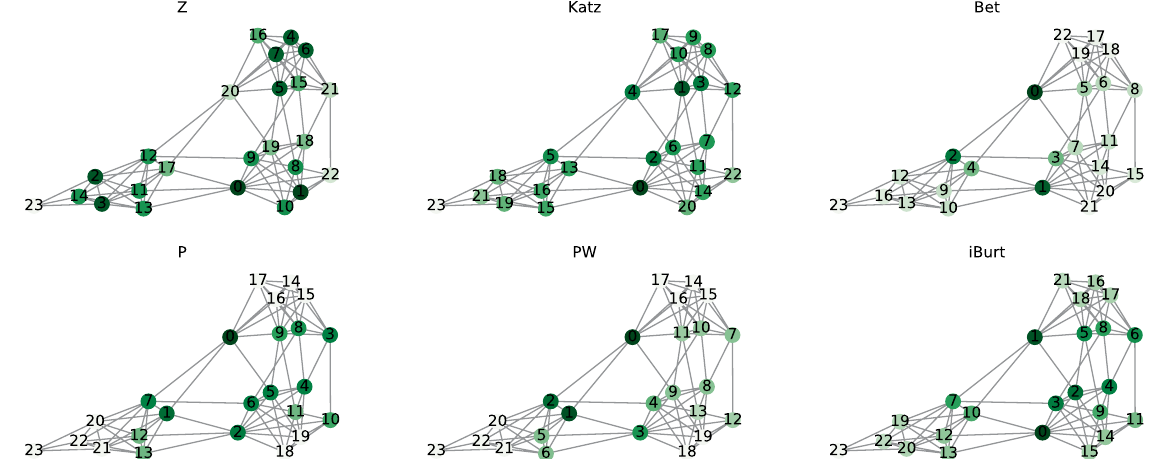
Figure 3. Index values of nodes in the RC network. Each network has 24 nodes and 84 edges with a rewiring probability of 0.2. The network had three communities named c1, c2, and c3 from the right to left. The color of the node represents the value of each index: Z, Katz, Bet, P, PW, and iBurt. The darker the color, the larger is the index value. The numbers on the nodes are their ranks in each index. The values of nodes can be found as Supplementary Table S2.